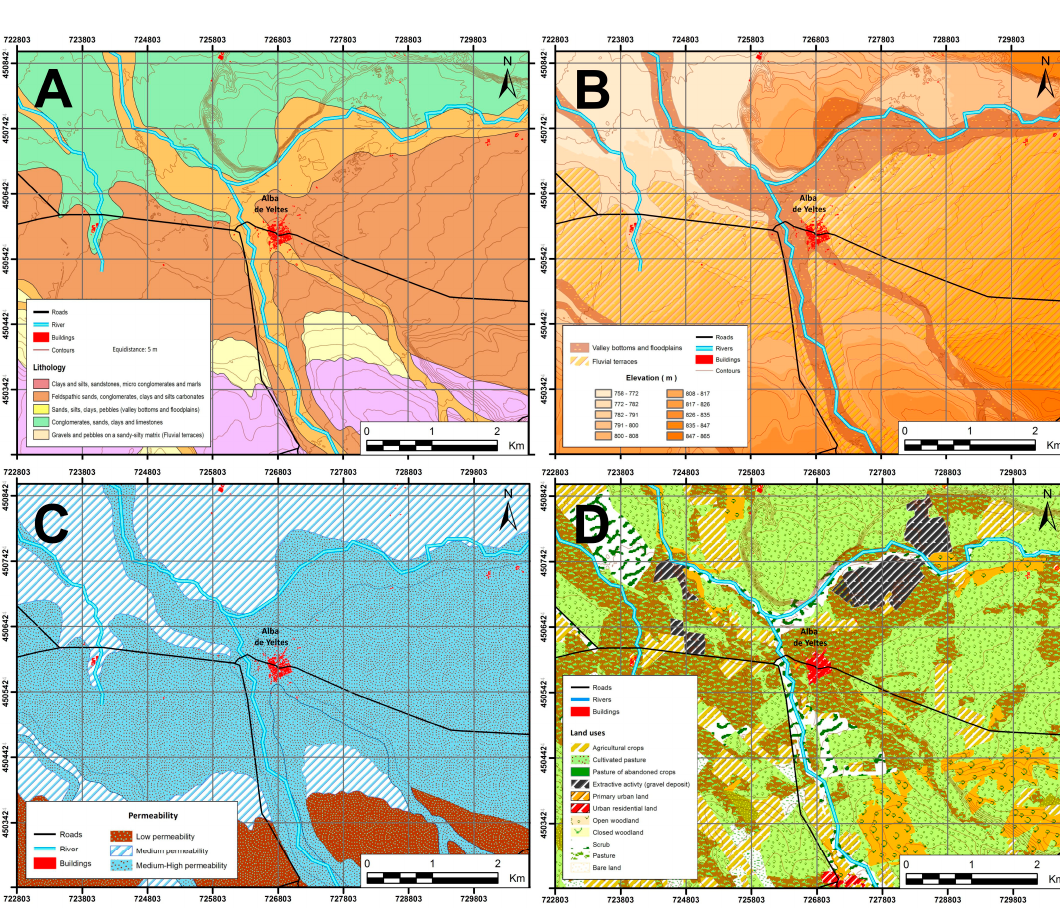
Figure 3. ( A ) Maps: geological; ( B ) geomorphological and elevation; ( C ) permeability; and ( D ) land use.